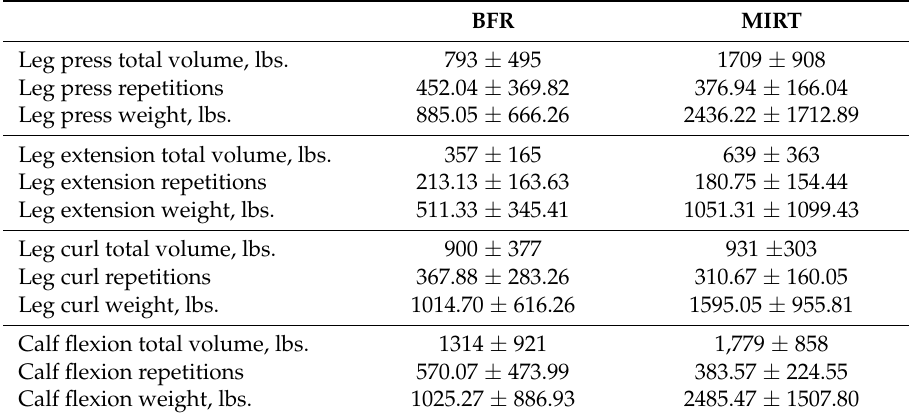
Table 2. Total volume, repetitions, and weight for each exercise by